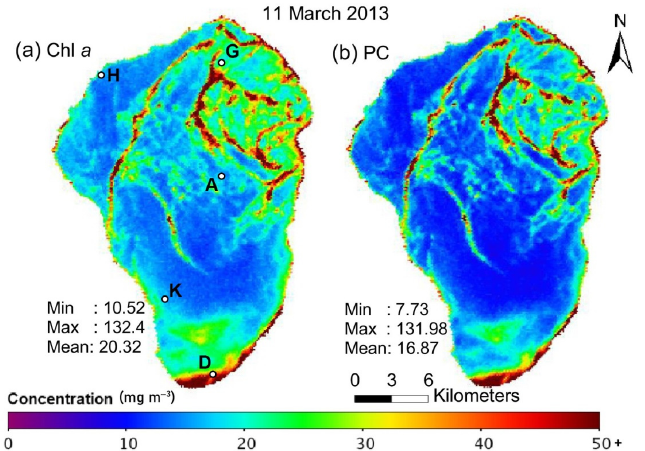
Figure 1. Distribution of ( a ) chlorophyll- a (Chl a ) and ( b ) cyanobacteria-specific pigment phycocyanin (PC) in the surface water layer of Lake Kinneret on 11 March 2013 (calculated using data of the HICO sensor installed at the International Space Station, the image is reproduced from ref. [43]). We have added the location of Stations A, D, G, H and K on panel ( a ).